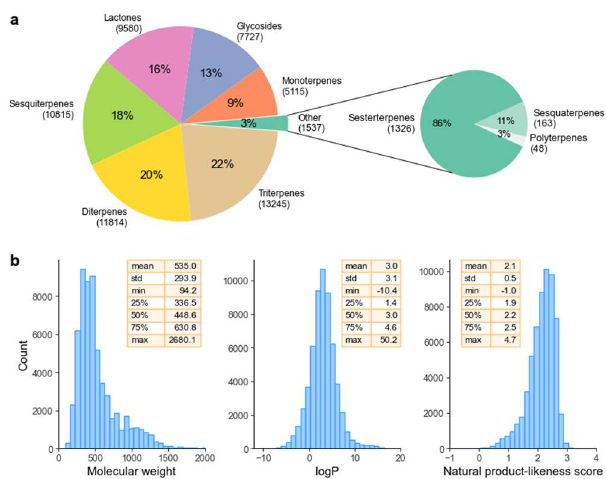
Figure 1. ( a ) Overview of absolute and relative counts of terpene subclasses. ( b ) Distribution of molecular weight, natural product-likeness score and logP for all terpenes in the dataset. For the sake of clarity, we have chosen only molecular weights up to 2000 and −12 < logP < 20, with only 0.2% and 0.1% of the molecules being suppressed, respectively.